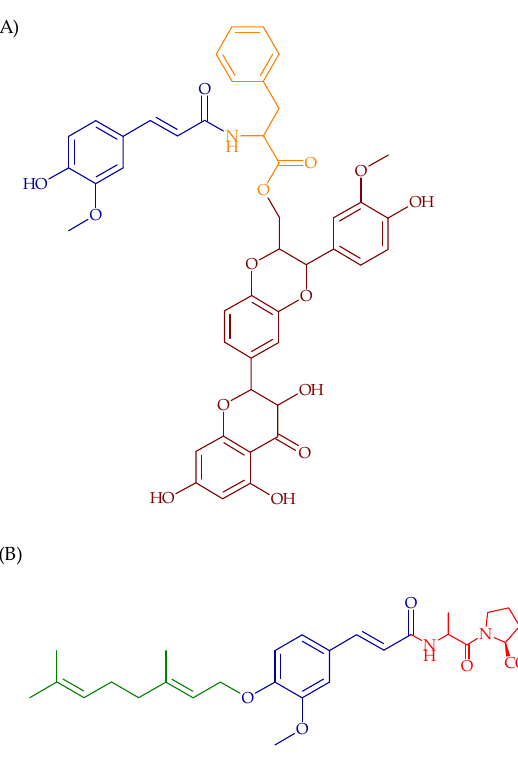
Figure 4. Chemical structures of ( A ) 1-phenylalanine- N -(4-hydroxy-3-methoxyphenyl) prop-2-en- O -(2R,3R)-3,5,7-trihydroxy-2-((2R,3R)-3-(4-hydroxy-3-methoxyphenyl)-2-(hydroxymethyl)-2,3-di- hydro-benzo-(1,4)-dioxin-6-yl)croman-4-one and ( B ) 3-(4 ′ geranyloxy-3 ′ -methoxyphenyl)-2- trans - dihydro-benzo-(1,4)-dioxin-6-yl)croman-4-one and ( B ) 3-(4 (cid:48) geranyloxy-3 (cid:48) -methoxyphenyl)-2- trans - propenoyl-L-alanyl-L-proline.